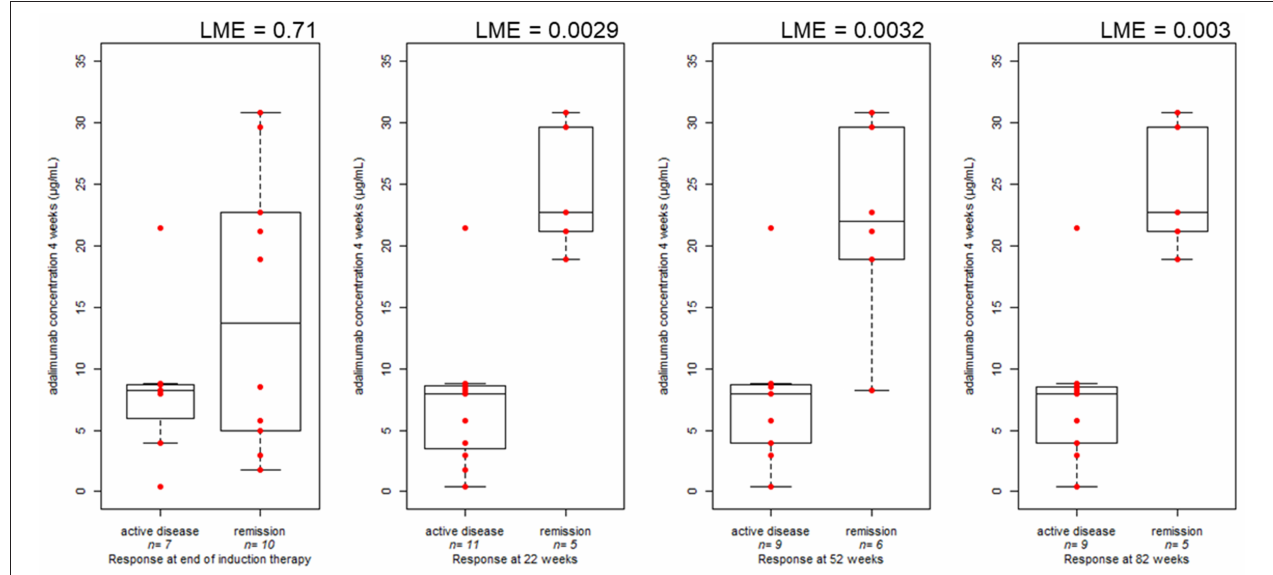
FIGURE 1 | Boxplot comparing clinical disease activity at the end of induction (17 measurements in 13 patients), at 22 (16 measurements in 12 patients), 52 (15 measurements in 11 patients), and 82 weeks (14 measurements in 10 patients) and serum adalimumab concentration during induction therapy (4 weeks). The bold horizontal line represents the median value. P -values are from linear mixed effect model (LME), accounting for repeated measures.